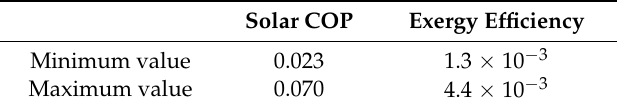
Table 5. Expected performance parameters for the combined system.